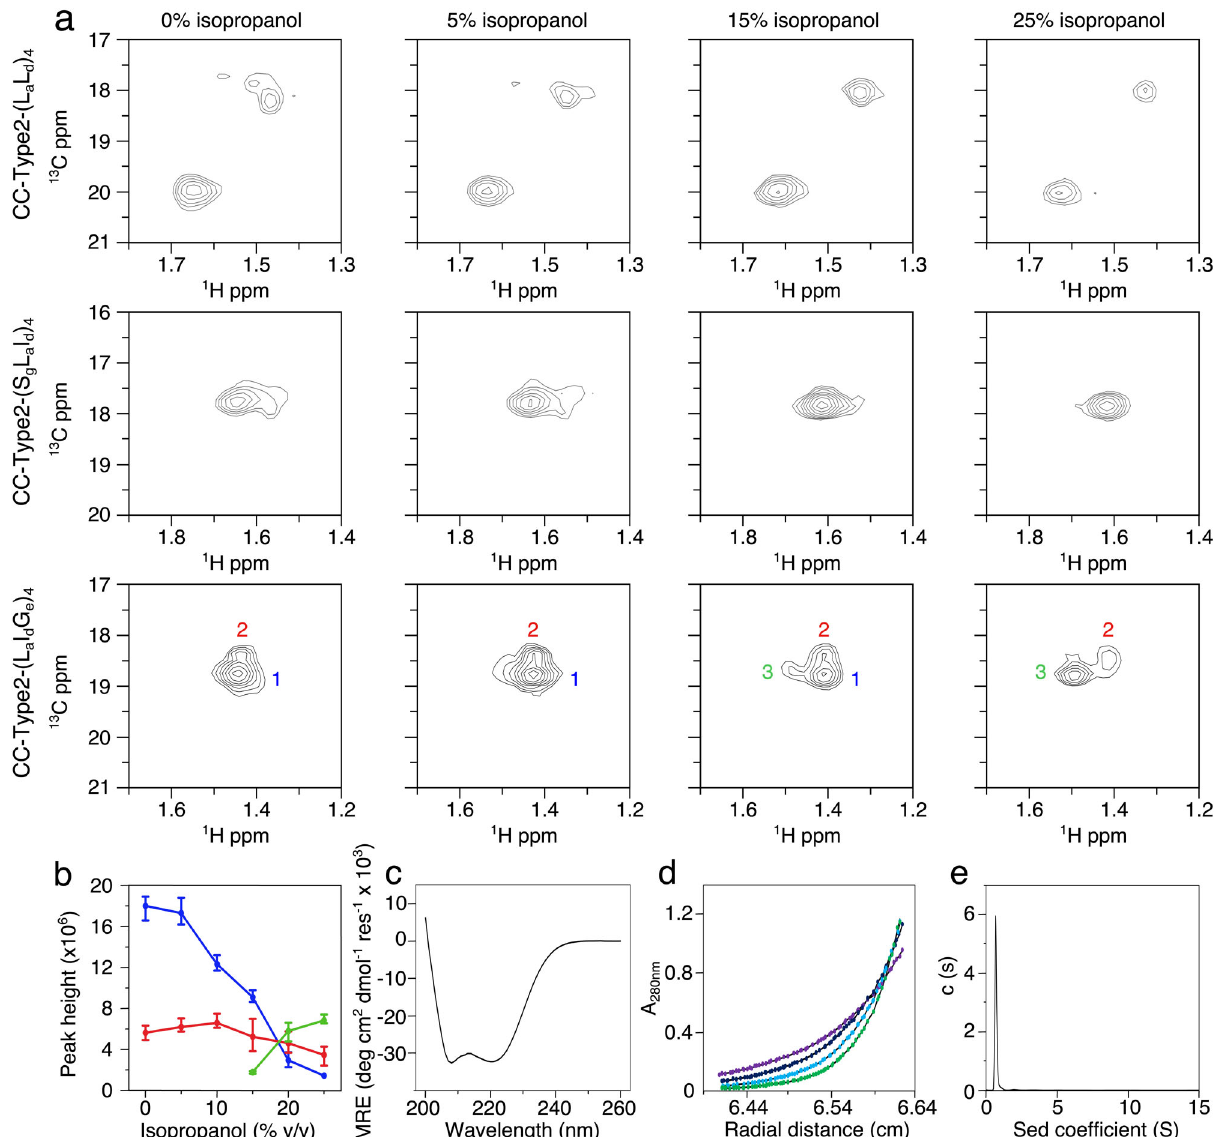
Fig. 4 Solution-phase NMR studies of de novo coiled coils. a Regions of 1 H- 13 C HSQC spectra showing 13 C-Ala peaks of CC-Type2-(L a L d ) 4 (top), CC- Type2-(S g L a I d ) 4 (middle), and CC-Type2-(L a I d G e ) 4 (bottom) through isopropanol titrations. ppm, parts per million. b Peak heights of CC-Type2-(L a I d G e ) 4 from n = 3 independent experiments. These are for peaks labelled for CC-Type2-(L a I d G e ) 4 in a peak 1, blue; peak 2, red; peak 3, green. Data are presented as mean values ± range. c CD spectrum of CC-Type2-(L a I d G e ) 4 with 5% v/v isopropanol at 20 °C. MRE, mean residue ellipticity. d